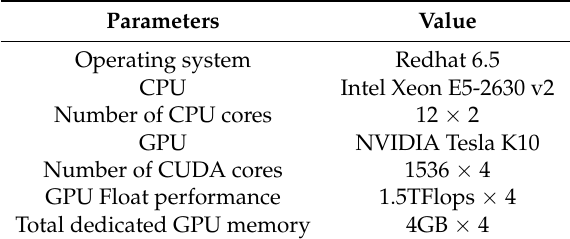
Table 2. Environment